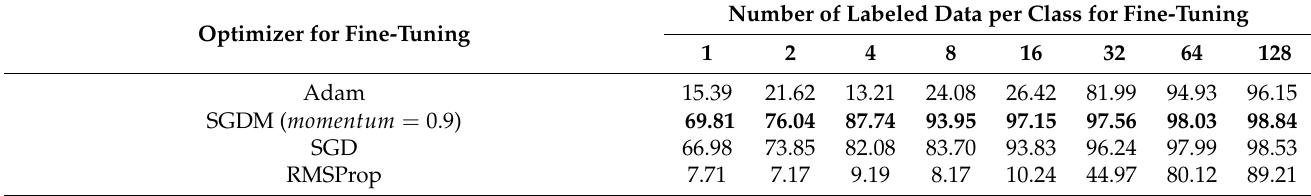
Table 9. The recognition accuracy (%) of the MsvNetLite with different optimizers for fine-tuning. The bold number is the best result in each